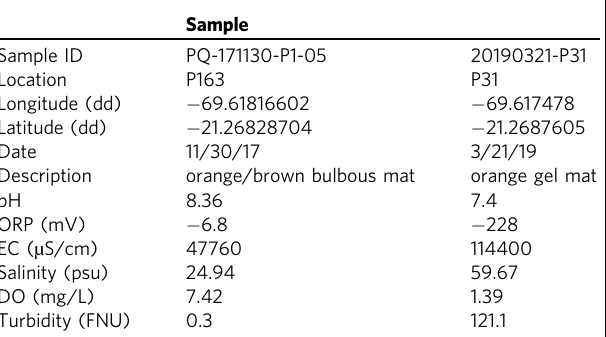
Table 1 Sample locations, descriptions, and in situ water parameter